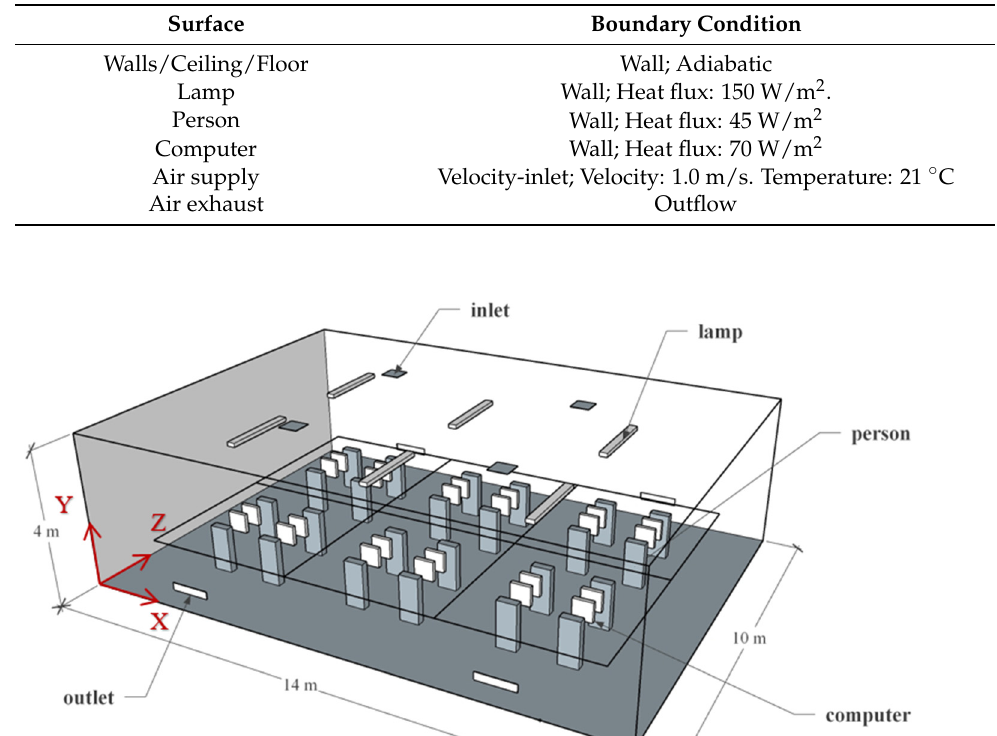
Table 1. Summary of numerical simulation conditions.